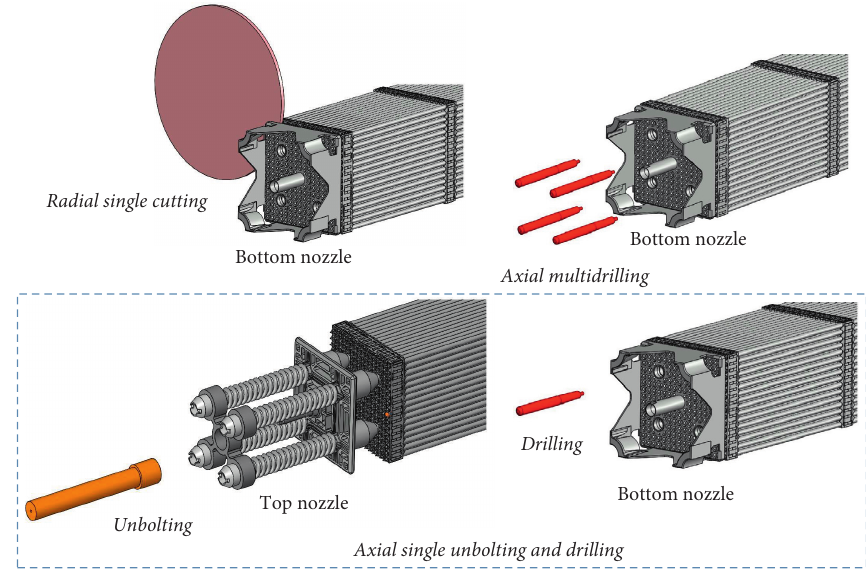
Figure 7: Dismantling methods for 16 × 16 PWR assembly.